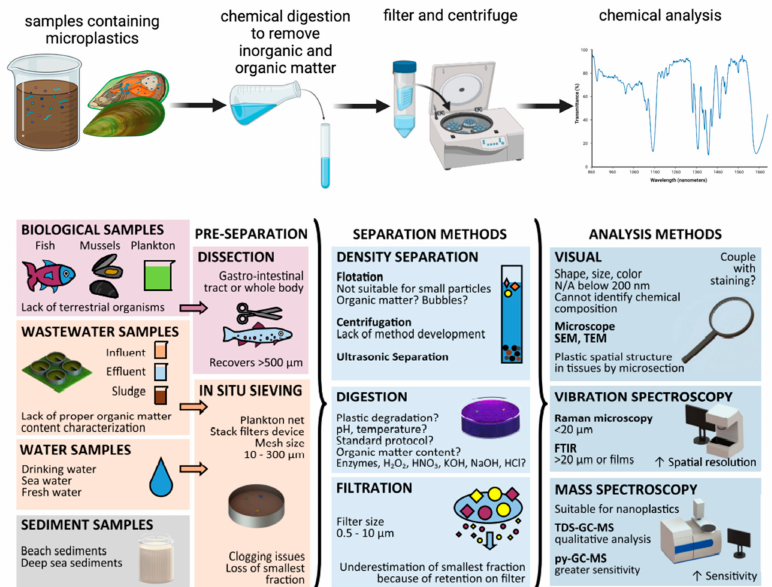
Figure 1. Top —General workflow for microplastics analysis. Samples are initially digested to dissolve and remove inorganic and organic materials before gravimetric or filtration-based separation. Finally, chemical analysis of microplastics can be achieved. Bottom —Overview of microplastics and nanoplastics separation and analysis methods in simple and complex matrices. Figure reproduced from [35] with permission of the